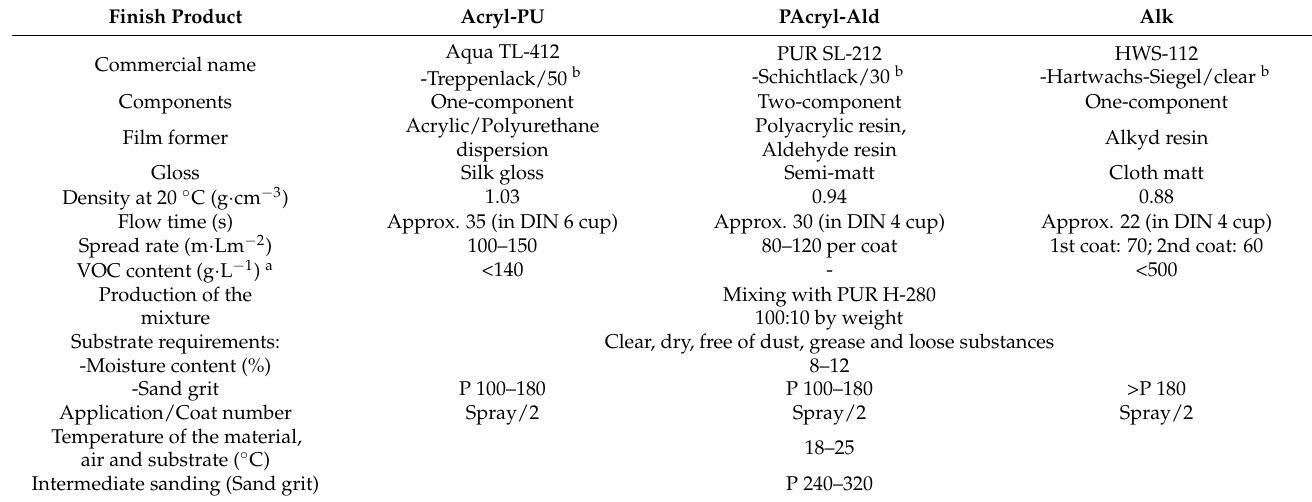
Table 1. Characteristics of finish products and their